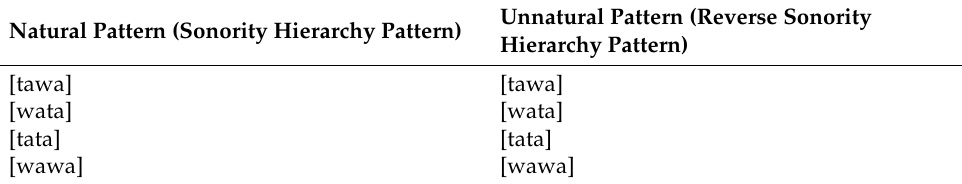
Table 4. One set of designs for exposure stimuli for control groups. Natural Pattern (Sonority Hierarchy